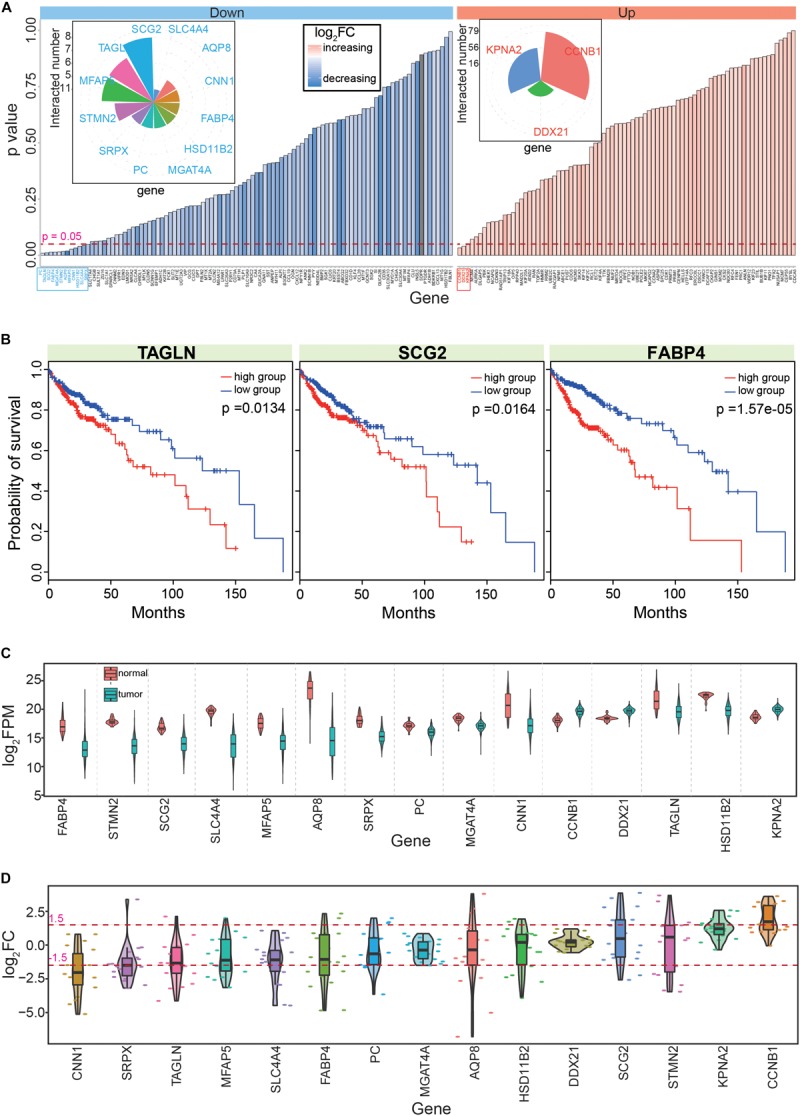
Screening the 15 candidate genes according to PPI networks and survival analyses. (A) Survival analyses of the 182 genes that are obtained from the PPI network; distributions of p values and their detailed fold change values are presented. The detailed numbers of significant gene interactions are also presented. Down shows down-regulated genes, up shows up-regulated genes, and log2FC shows fold change of each gene in tumor samples. Genes with significant correlations with cancer prognosis are highlighted in blue or red. (B) Examples of genes with significant correlations with CRC prognosis. (C) Expression patterns of the 15 screened hub genes. Normal means normal (non-cancerous) samples, and tumor means tumor samples. (D) Distributions of the abnormal expression patterns of the 15 hub genes via a pan-cancer analysis.